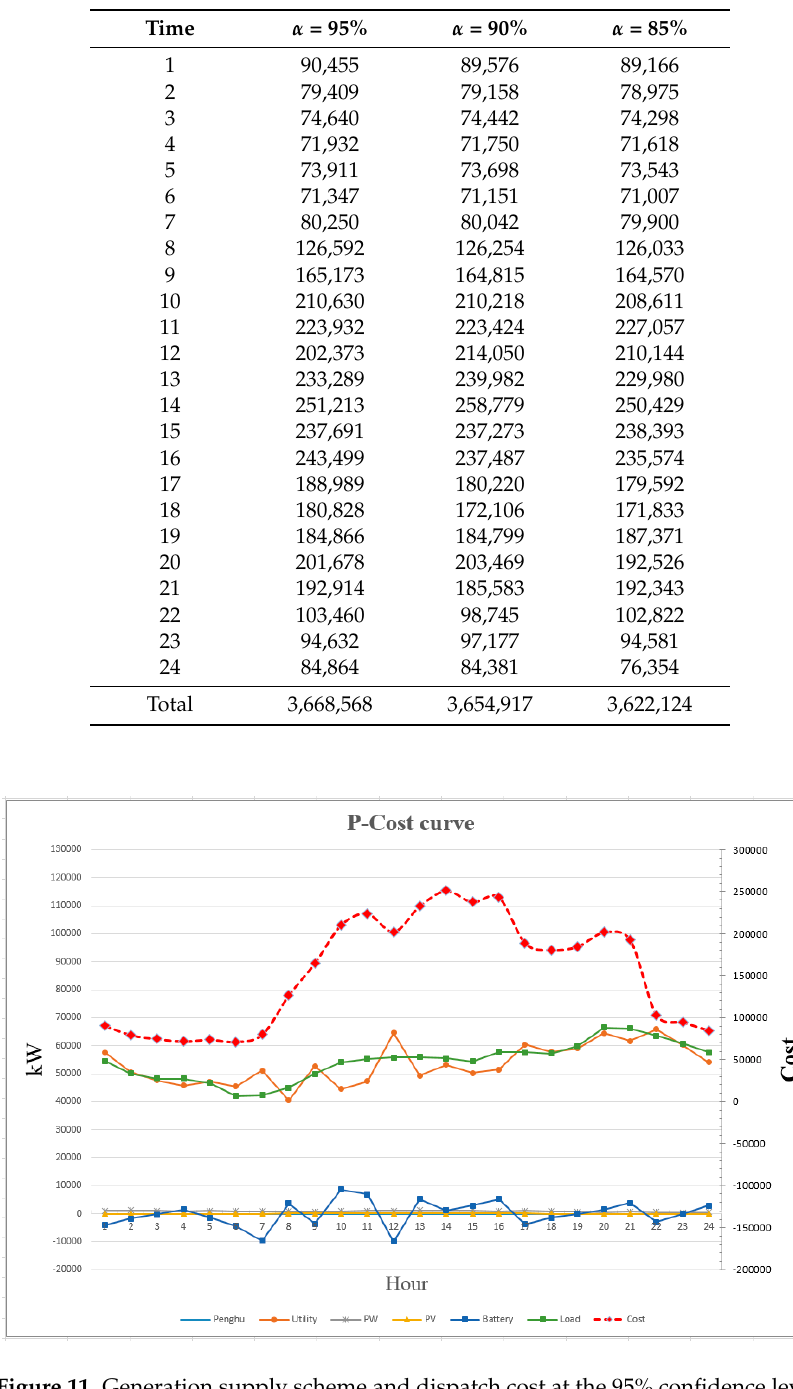
Figure 12. Generation supply scheme in the stand-alone scenario.